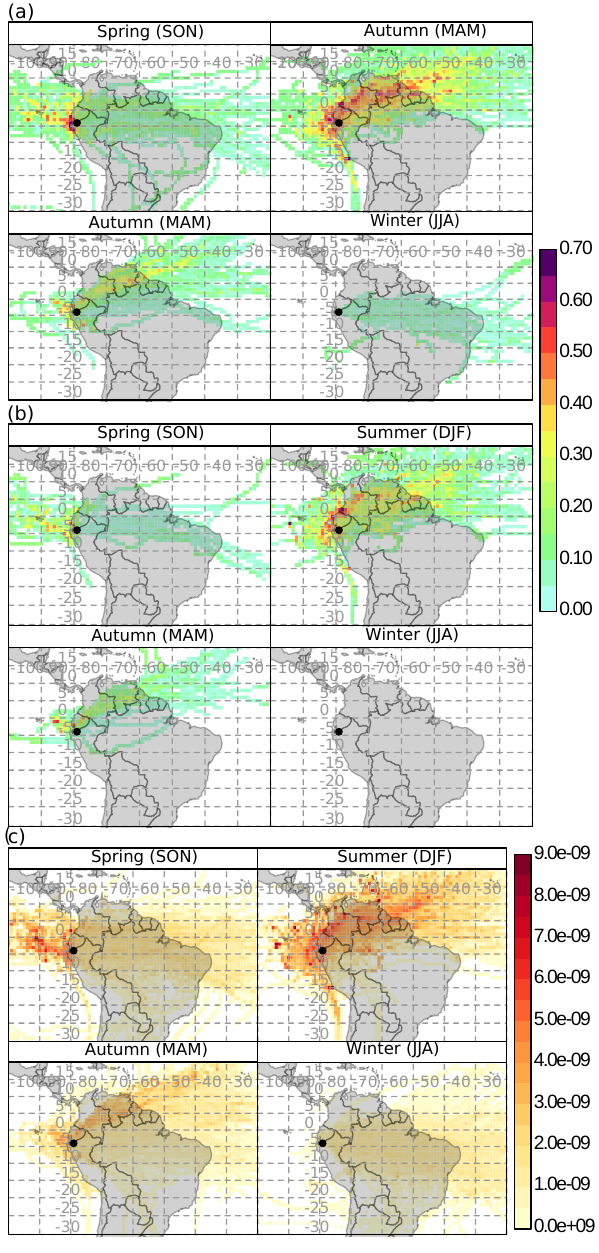
Figure 5. Seasonal sea salt source maps according to (a) PSCF with concentration threshold at 75th percentile, (b) PSCF with concen- tration threshold at 90th percentile, and (c) CWT; the back trajectory starting height is 3180m at the